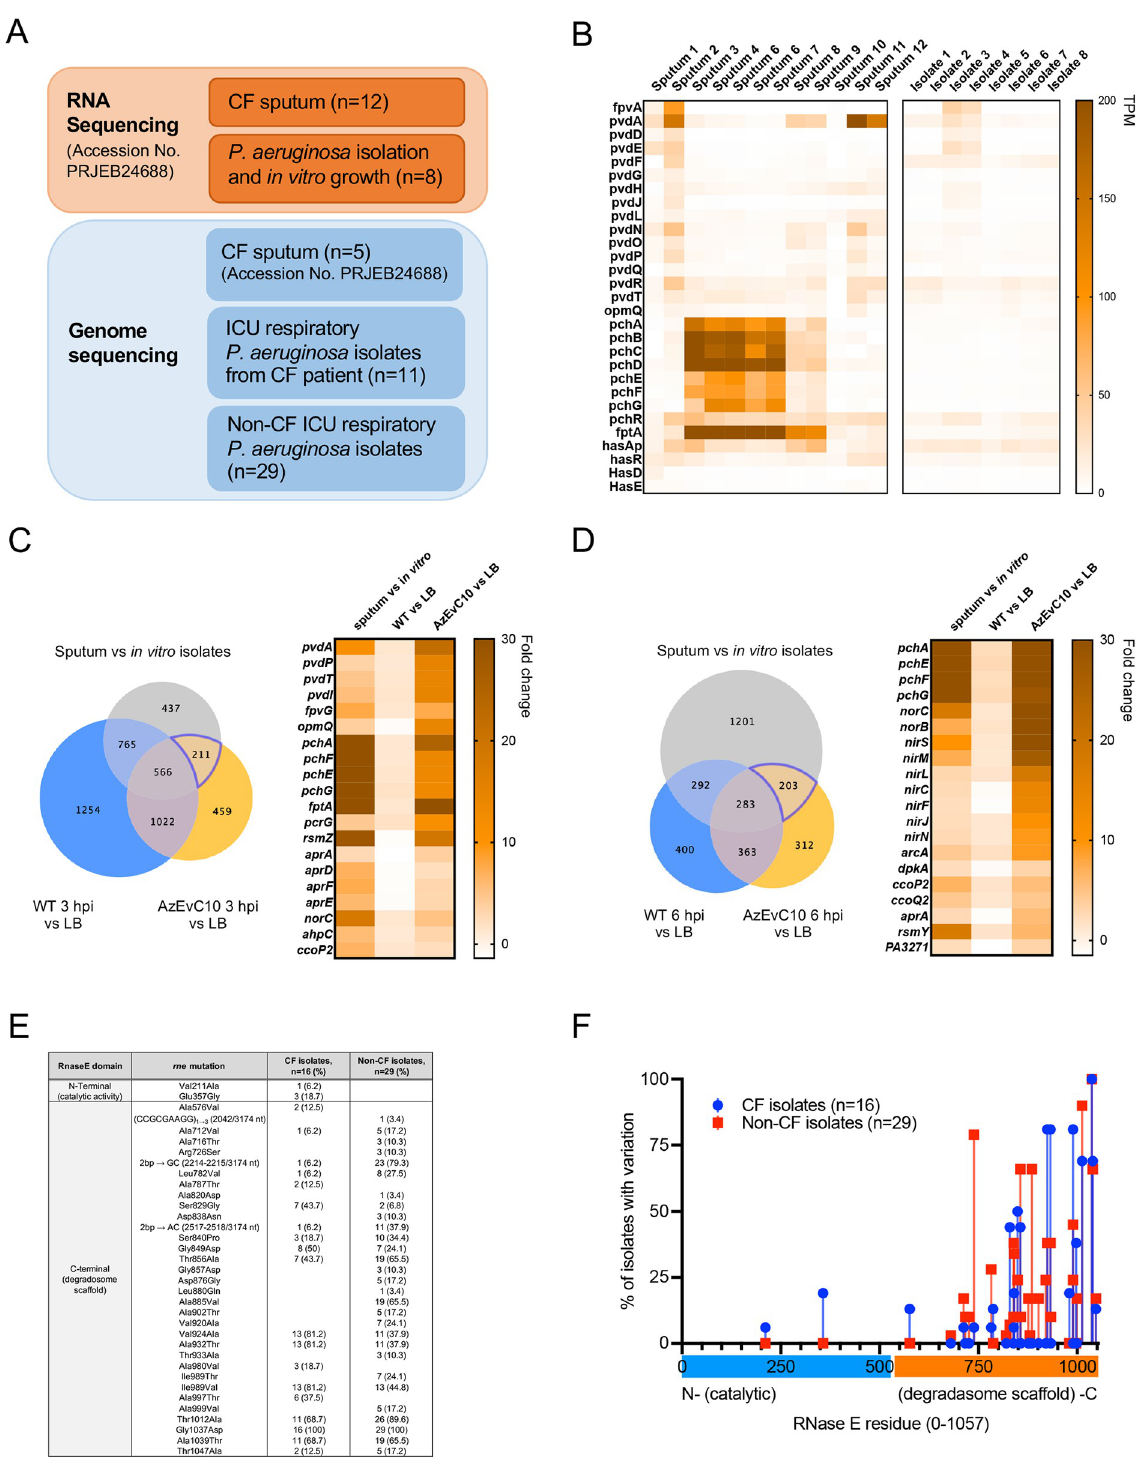
Fig 7. Virulence and metabolic adaptation are common features of P . aeruginosa pulmonary infections. A. Schematic representation of the experimental design for RNA and whole genome sequencing of P . aeruginosa clinical isolates. B. Individual expression of iron acquisition genes in CF sputum (n = 12) and in vitro grown clinical isolates (n = 8) expressed in normalized number of reads (TPM) C-D. Expression of selected iron and metabolic genes commonly upregulated by clinical isolates in sputum and by the AzEvC10 mutant during BMDM infection at 3 hpi (C) and 6 hpi (D) (n = 2–5). E. List of non-synonymous mutations detected in the rne gene in P . aeruginosa clinical isolates. F.